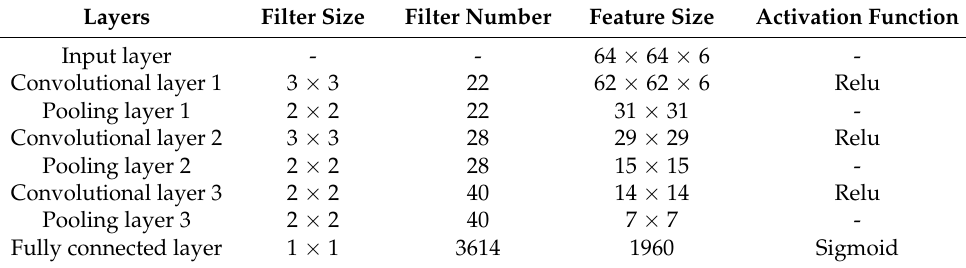
Table 5. The structural parameters of